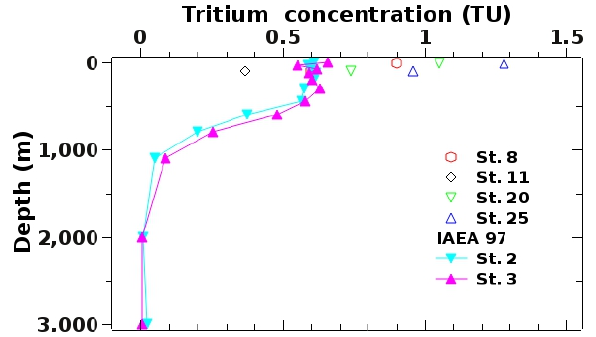
Fig. 4. A comparison of 3 H profiles as obtained from the IAEA’97 expedition (global fallout impact; Povinec et al., 2010) with the re- sults presented in this paper, which are based on analysis of seawa- ter samples collected during the KOK expedition (Fukushima im- pact) in the NW Pacific Ocean. IAEA’97 data were decay-corrected to June